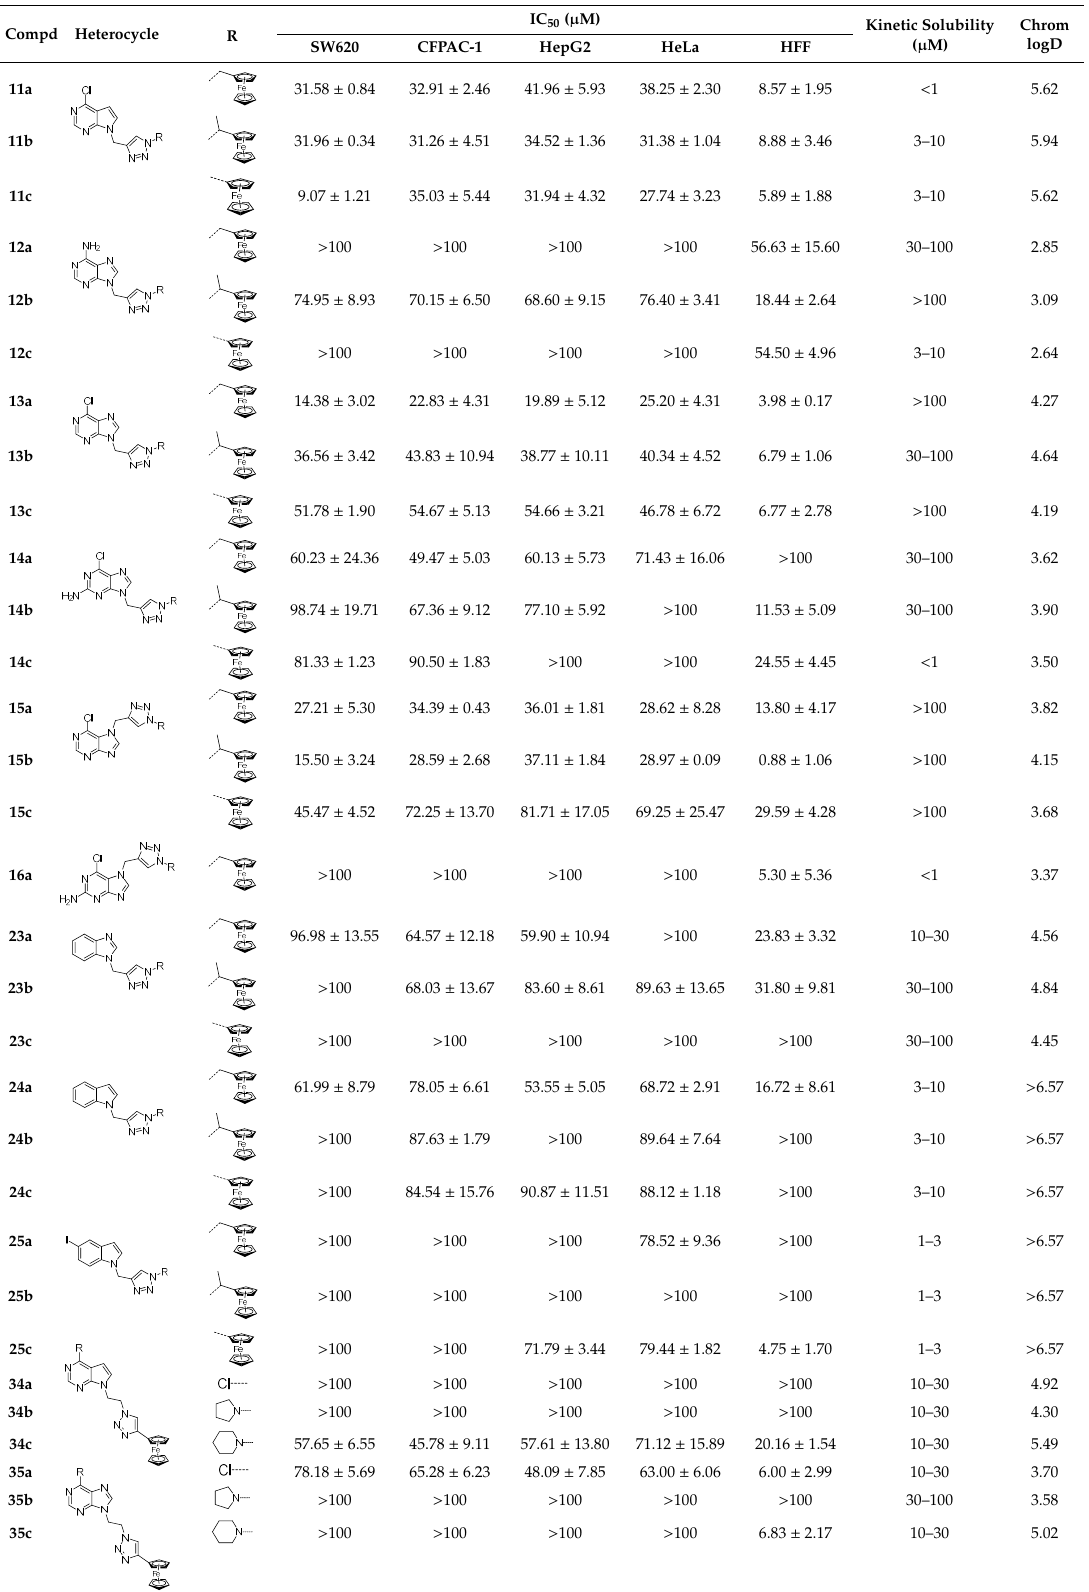
Table 1. In vitro growth inhibitory effects of compounds 11a − 11c , 12a − 12c , 13a − 13c , 14a − 14c , 15a − 15c , 16a , 23a − 23c , 24a − 24c , 25a − 25c , 34a − 34c and 35a − 35c on selected tumor cell lines and their measured kinetic solubility range and Chrom logD. Compd